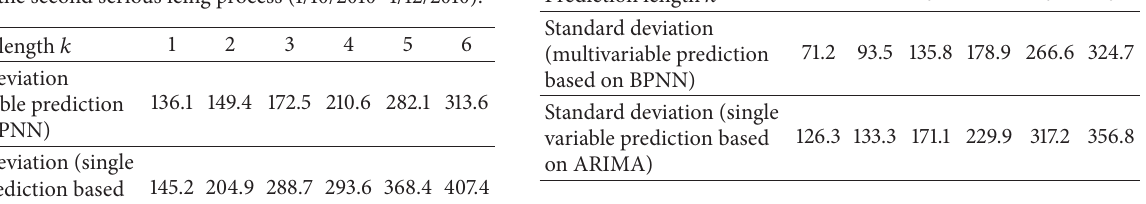
Figure 6: Results of prediction in same icing process ( 𝑘 = 1 ) for the second serious icing process (1/10/2010 ∼ 1/12/2010). Table 3: The error variances of icing load prediction in same icing process for the second serious icing process (1/10/2010 ∼ 1/12/2010).